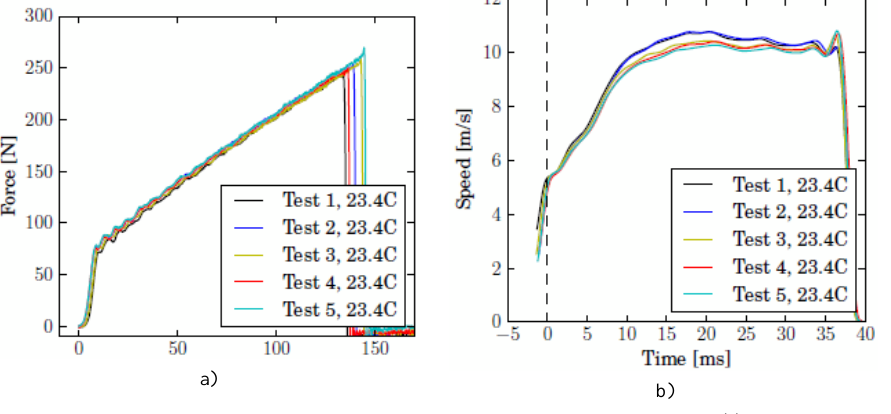
Fig. 7 Uniaxial tensile tests of PVB at 10 m/s: measured forces (a), and recorded speed (b).